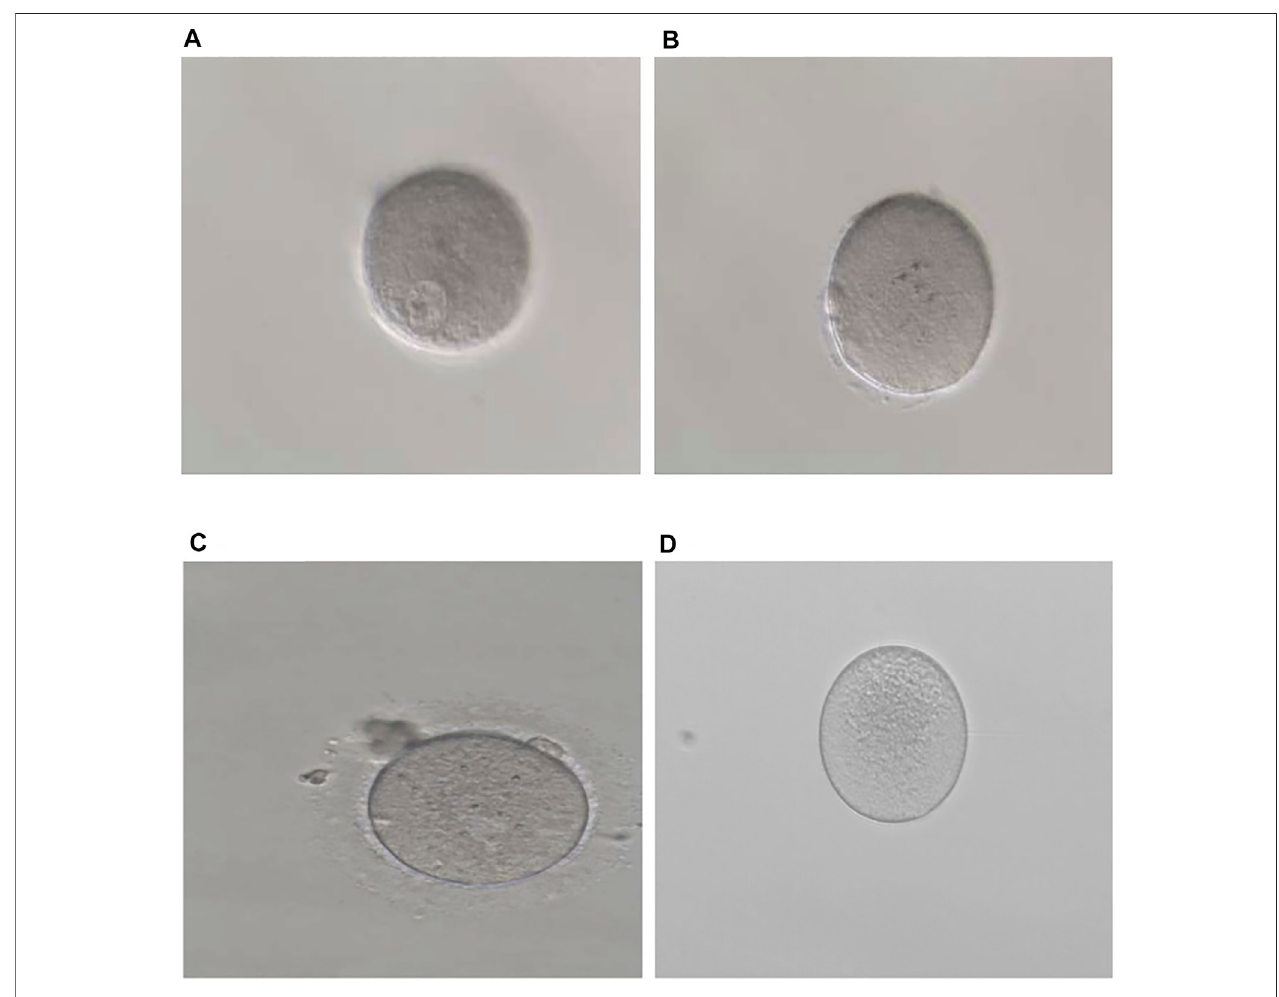
FIGURE 1 | Phenotypes of oocytes from patients with maturation arrest. (A) Oocyte at GV (family 1). (B) Oocyte at MI (family 5). (C) Oocyte at MII (family 9). (D) Oocyte without ZP (family 7).